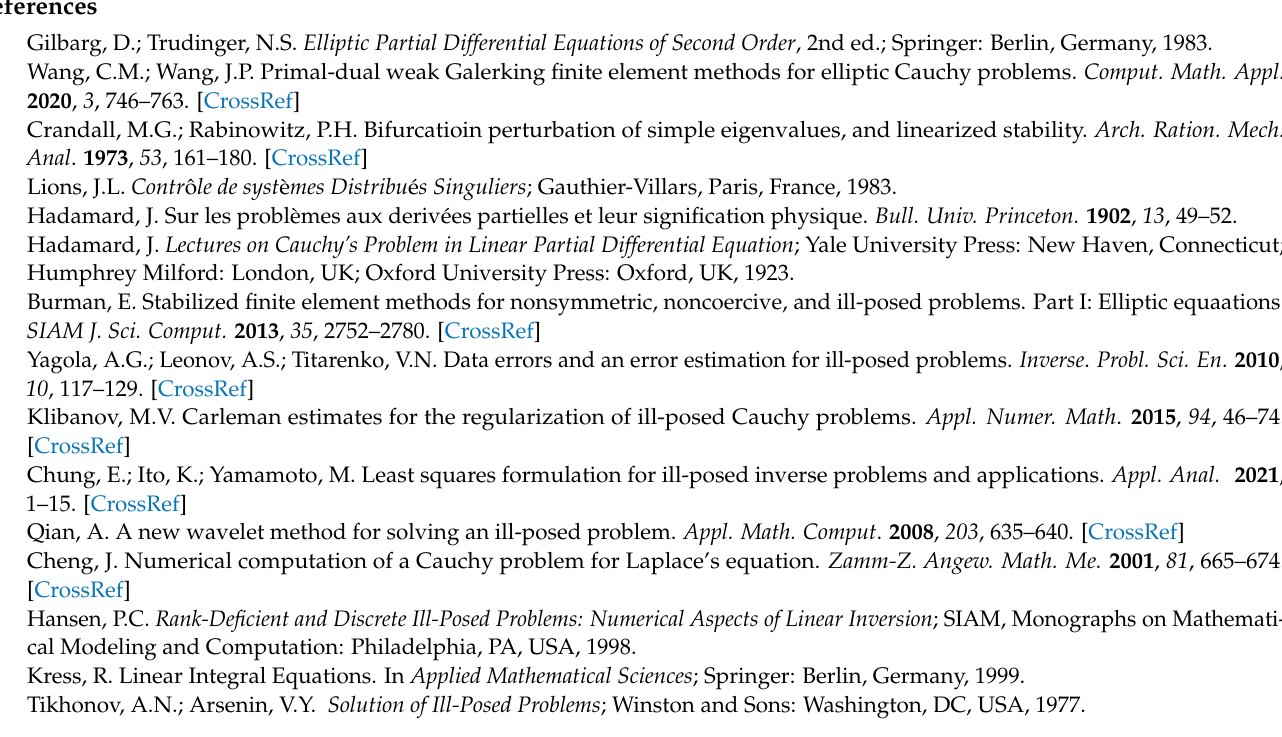
Figure 12. Numerical solution u h of B.C. Figure 11. exact solution u = x 2 + e y Figure 12. numerical solution u h of B.C. V